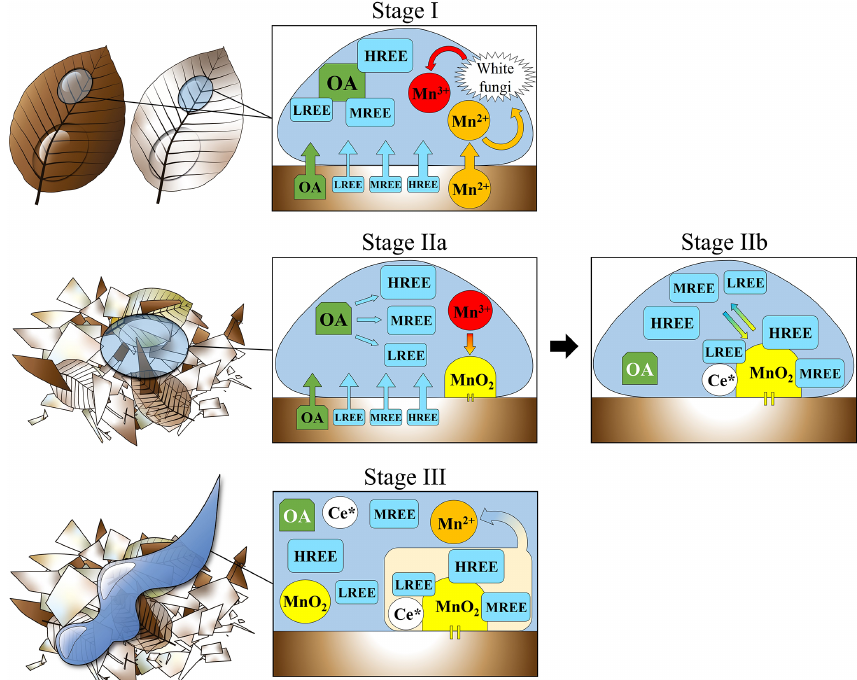
Figure 5. Conceptual model representing the main processes treated in this study occurring during the litter degradation. Stage I – Do OLn, Be OLn and Be OLv degradation: Preferential release of HREE and MREE linked to their affinity for organic acids; REE complexation with organic acids and subsequent inhibition of Ce anomalies and tetrad effect; transformation of Mn 2 + (coming from the litter) into Mn 3 + operated by white fungi. Stage IIa – Do OLv and Be OF degradation: Preferential release of HREE and MREE linked to their affinity for organic acids; REE complexation with organic acids and subsequent inhibition of Ce anomalies and tetrad effect; accumulation and precipitation of Mn 3 + under the form of Mn oxides; decrease in the OA / MnO 2 ratios (due to increased concentration of MnO 2 and decreased release of organic acids), leads to the REE–organic acid dissociation. Stage IIb – Do OLv and Be OF degradation: REE released from the organic acids in Stage IIa are re-adsorbed onto MnO 2 positioned on the litter surface; scavenging of Ce and its subsequential enrichment on the Mn oxide surface. Stage III – Do OLv and Be OF degradation: Higher volume of water and higher turbulence lead to the dissolution and/or direct transportation of the Ce-enriched Mn oxides into solution, which inherits the enrichment in Ce and develops a tetrad effect (Be OF